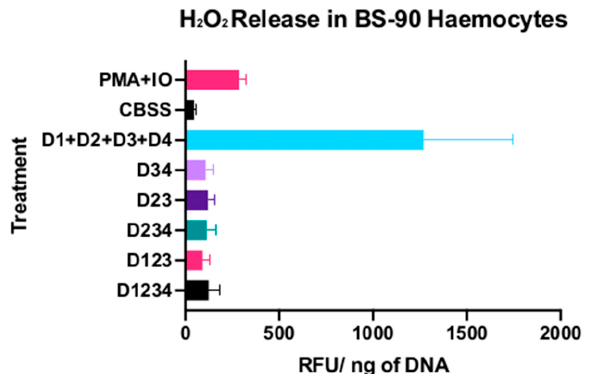
Figure 3. H 2 O 2 production ( n = 9) by BS-90 haemocytes in response to treatment with BgGRN (D1234), its intermediate forms (D34, D23, D123, D234), as well as its individual domains (D1,D2,D3,D4). Bars represent SD. Different letters indicate statistically significant ( p < 0.05) differences between particular groups and different groups bearing other letters. Genes 2020 , 11 , x FOR PEER REVIEW